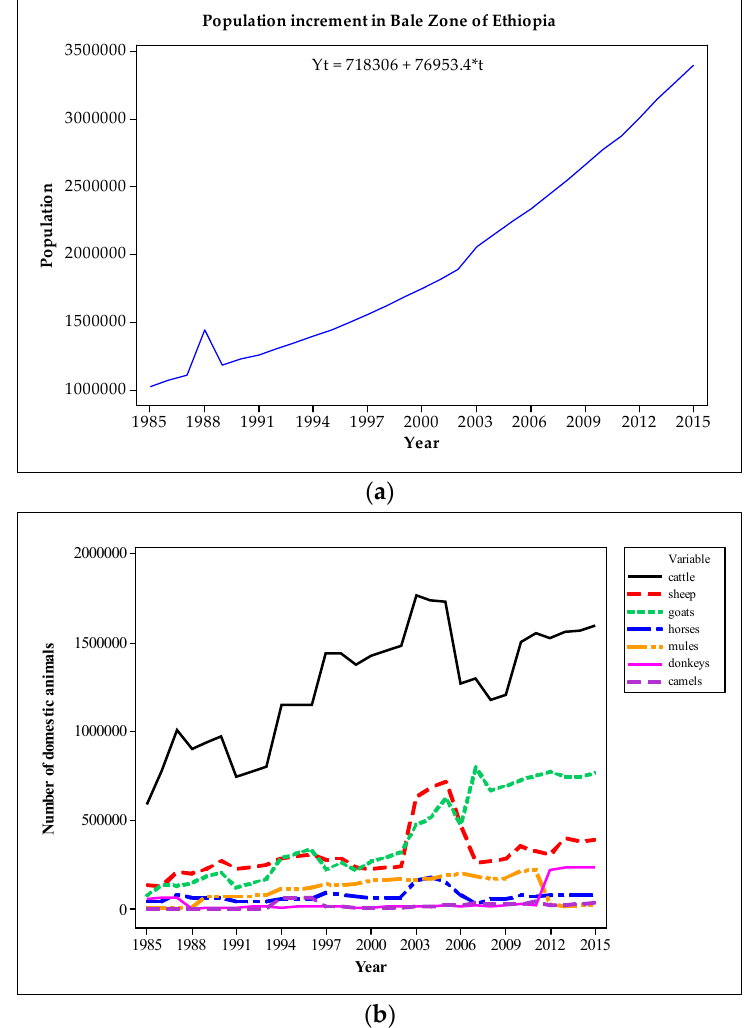
Figure 7. Human ( a ) and livestock ( b ) population growth in the Bale Zone. Data are from the Central Statistics Agency of Ethiopia.